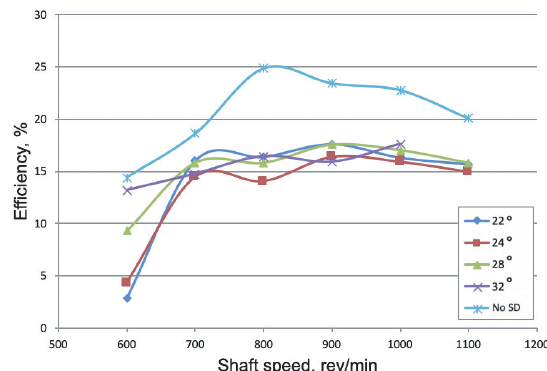
Figure 5. Pump efficiency as a function of the shaft speed for different SD